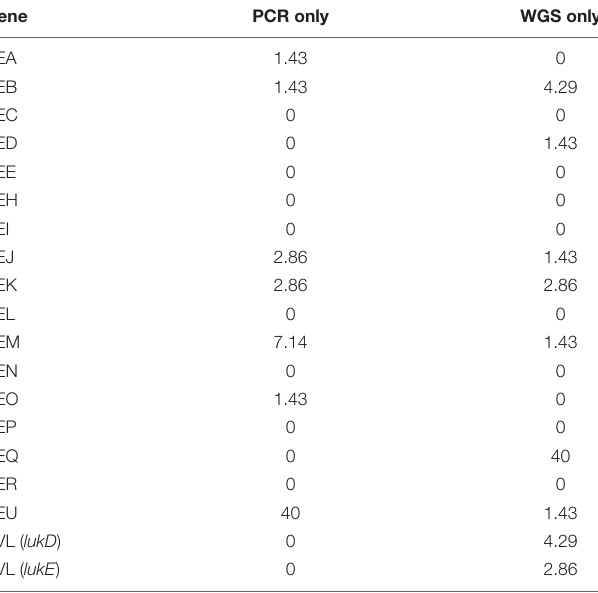
TABLE 2 | The congruence of enterotoxin genes detected by both the PCR assay and WGS analysis are expressed here as a percentage.